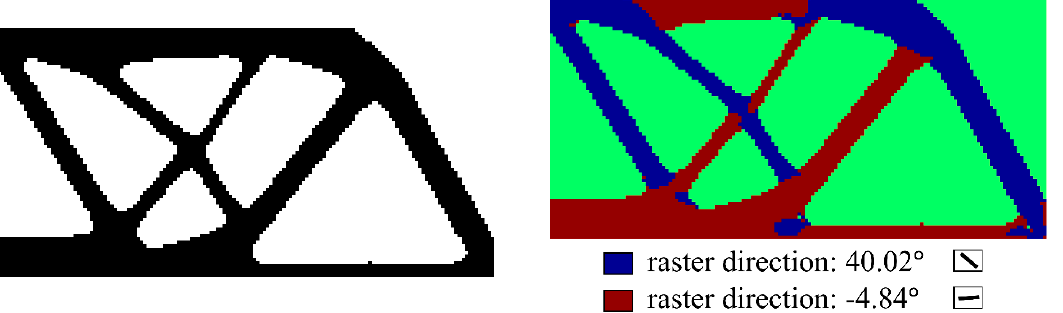
Figure 13. MBB structure optimization result with a finer mesh (compliance = 86.95J). (The blue color shows the converged ρ e 1 = 1 , the red color shows the converged ρ e 2 = 1 , and the green color shows the misconverged or void areas).